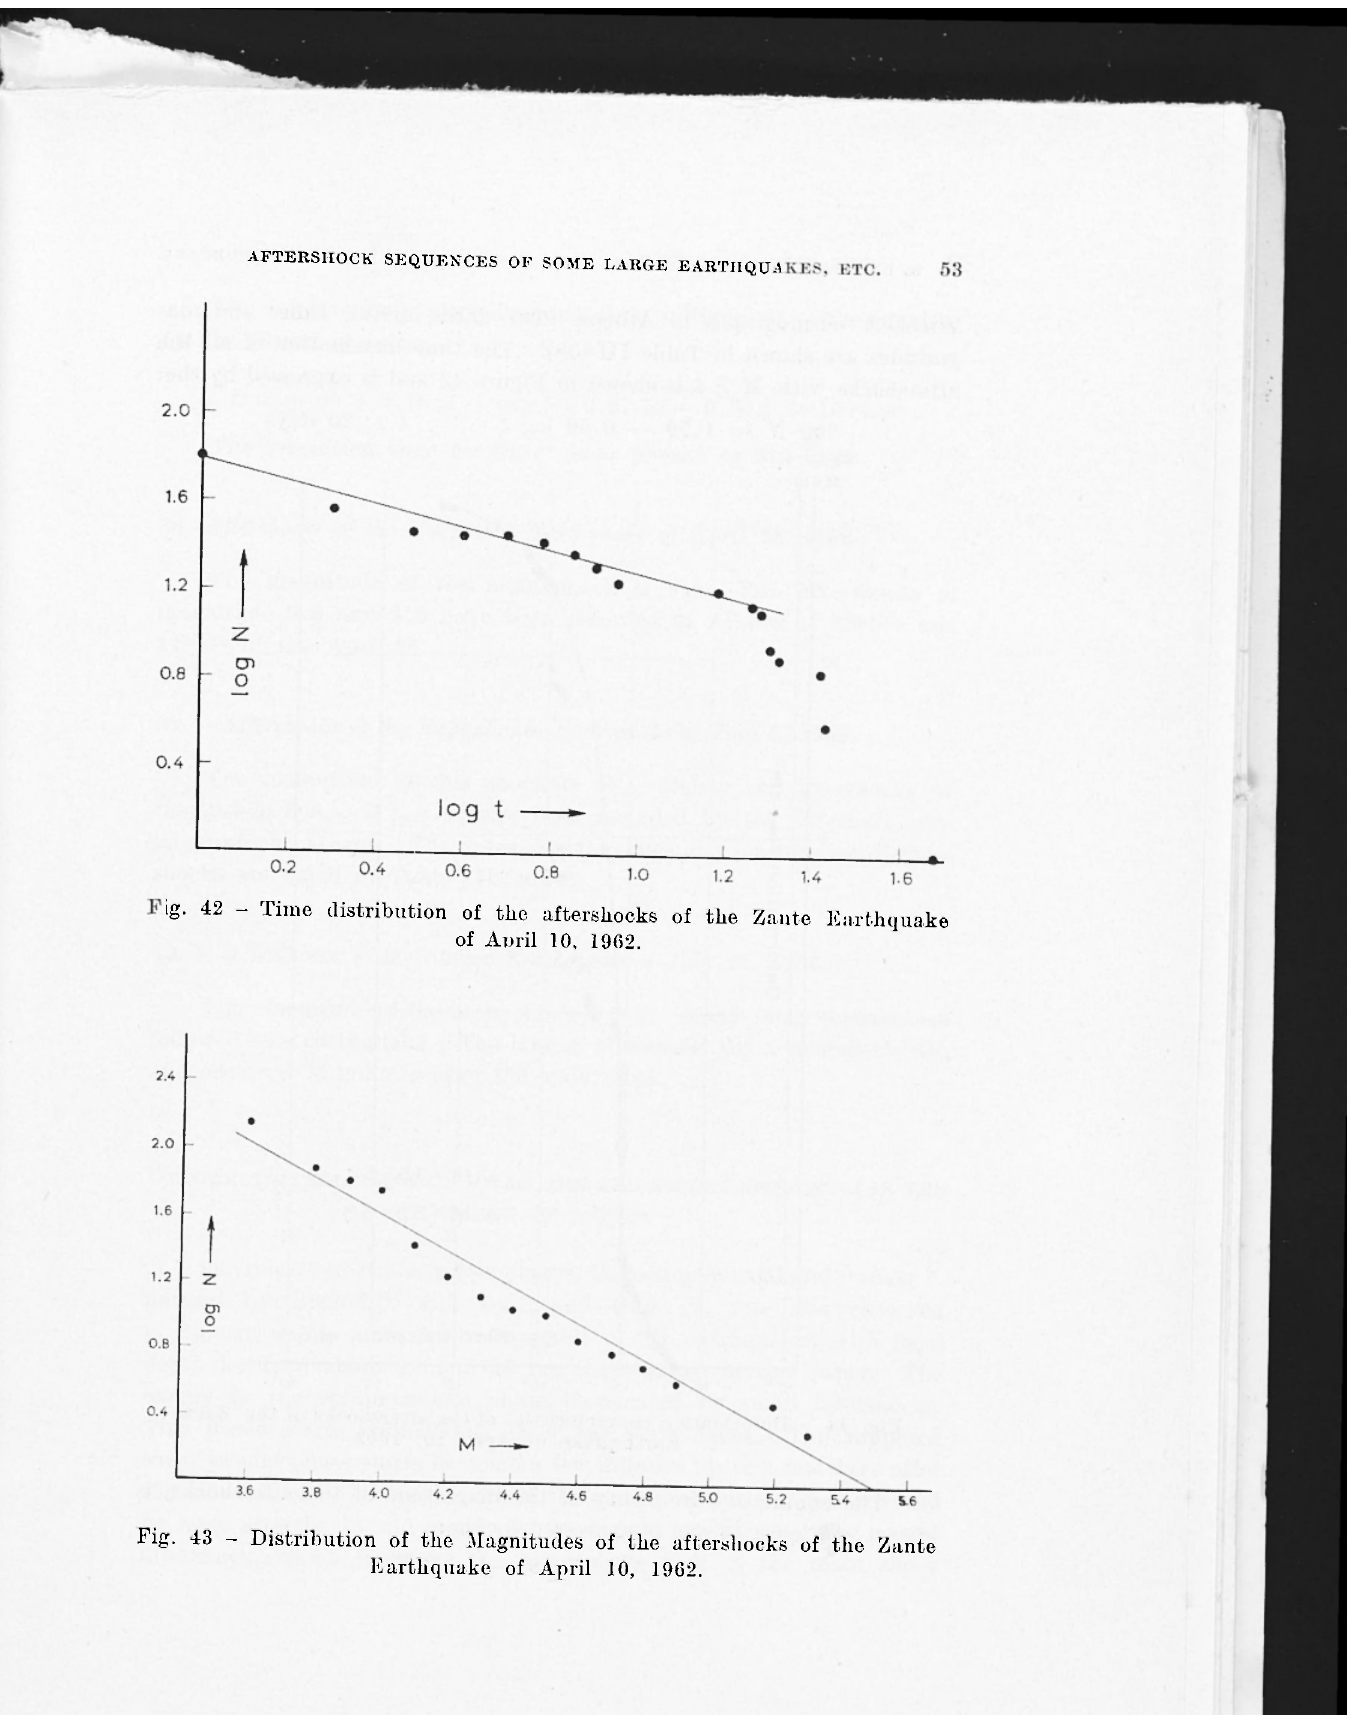
Fig. 43 - Distribution of the Magnitudes of the aftershocks of the Zante Earthquake of April 10,